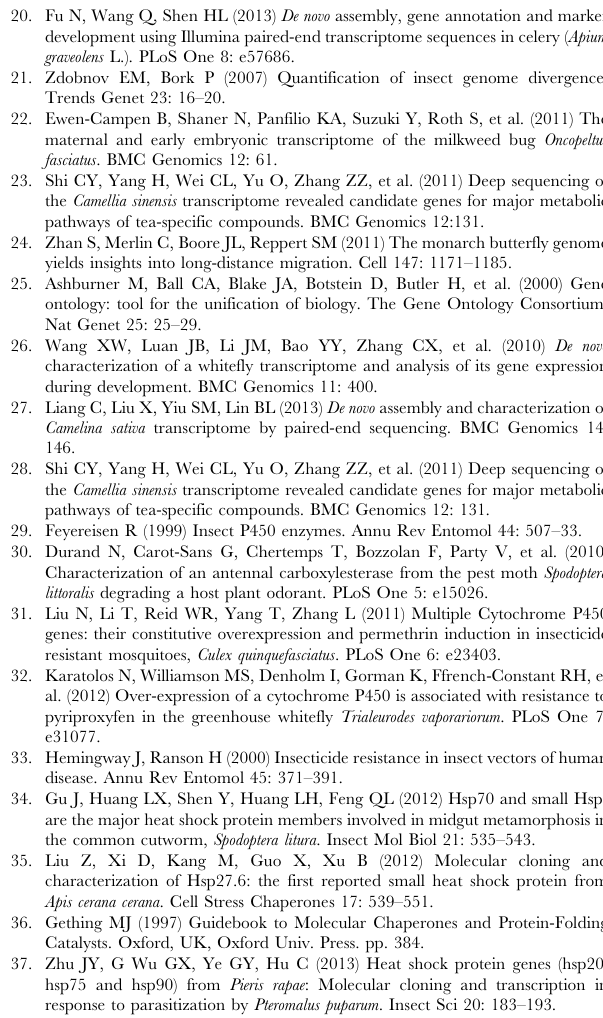
Figure S5 Amino acid alignment of predicted Rhyacio- nia leptotubula Hsp70 to that of other insect species. Conserved residues are shaded. Abbreviations are the same as Figure 4. (PPT) Figure S6 Amino acid alignment of predicted Rhyacio- nia leptotubula Hsp90 to that of other insect species. Conserved residues are shaded. Abbreviations are the same as Figure 4. (PPT) Figure S7 Amino acid alignment of predicted Rhyacio- nia leptotubula Hsp105/110 to that of other insect species. Conserved residues are shaded. Abbreviations are the same as Figure 4. Table S1 Top Blastx hits of the unigenes against NCBI Nr database with an E-value cut-off 10 2 5 . Table S2 The number of unigenes annotated in the public database.